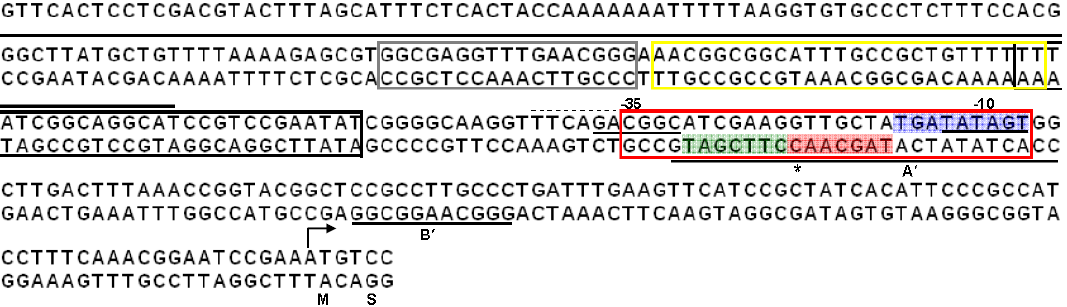
Figure 2. The nucleotide sequence upstream of glnE and MtrR-binding sites. The 301 bp sequence of the DNA upstream of glnE and the first two codons (encoding M and S, respectively) is shown with the annotated −10 and −35 hexamer sequences of the glnE promoter identified by a line under the sequences. The putative extended −10 element is shown in blue. The alternative −35 hexamer is shown by the dashed line above the sequence. The boxed regions represent predicted MtrR binding sites that were identified based on sequence similarity to that of a site upstream of mtrCDE [8,10] or rpoH [7]. The grey box represents a sequence with 53% identity to the region upstream of rpoH [7] while the yellow, black, and red boxes represent sequences with 55%, 67%, and 52%, respectively, identity to regions upstream of mtrCDE [8,10]. The MtrR-binding sites identified by DNase I protection (Figure 3) are noted by the solid line above the sense strand or below the anti-sense strand; the two sites on the anti-sense strand are denoted as A′ and B′ with the DNase I hypersensitive site in A′ shown by an * . The adjacent seven nucleotide imperfect inverted element is shown in green and